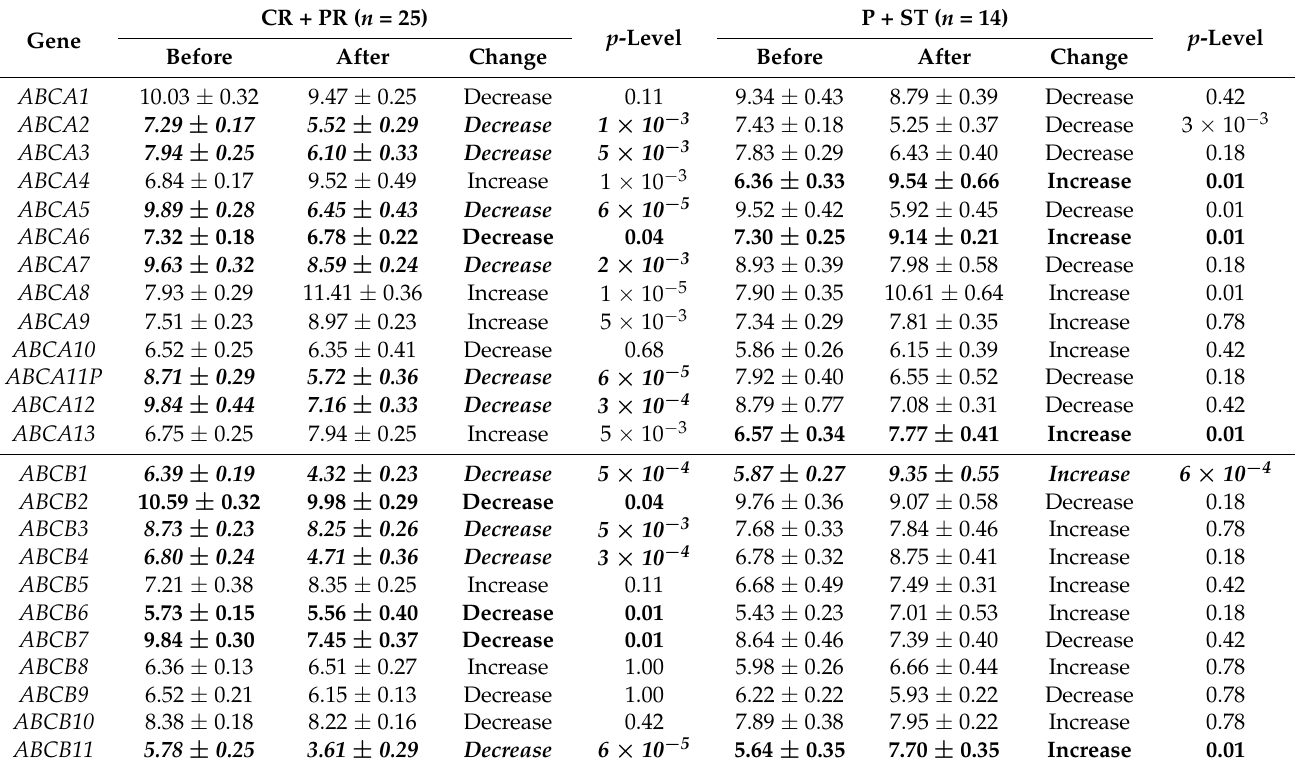
Table 3. Expression of ABC transporters in patients with breast cancer before and after neoadjuvant treatment depending on NAC